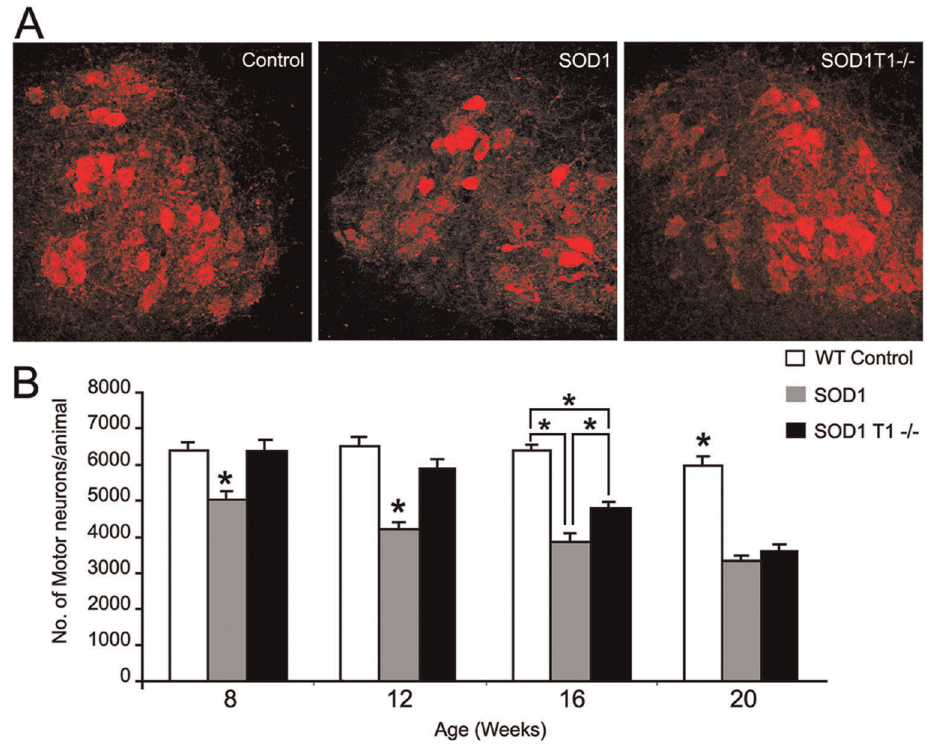
Figure 1. Effect of TrkB.T1 deletion on motoneuron degeneration. (A) Representative immunofluorescent images of lumbar spinal cord showing ChAT-positive motoneurons in 8-week-old animals. In comparison to age-matched WT controls, SOD1 transgenic mice show a small but significant loss of motoneurons. This loss was prevented by deletion of TrkB.T1 in these mice (SOD1T1 2 / 2 ). (B) Histogram showing number of motor neurons at 8, 12, 16 and 20 weeks. Cell counts show a progressive decrease in number of motoneurons in SOD1 animals as compared to WT controls. The deletion of TrkB.T1 in SOD1 transgenic mice completely rescues this loss at 8 and 12 weeks. At 16 weeks this neuroprotection is partial and significant whereas at 20 weeks it is completely lost such that both the SOD1 and SOD1T1 2 / 2 groups show severe reduction in motoneuron numbers as compared to WT animals. The data are the Mean 6 SEM. * indicates P , 0.05. N=6 in each group. Statistical analysis by ANOVA followed by post-hoc Tukey test.